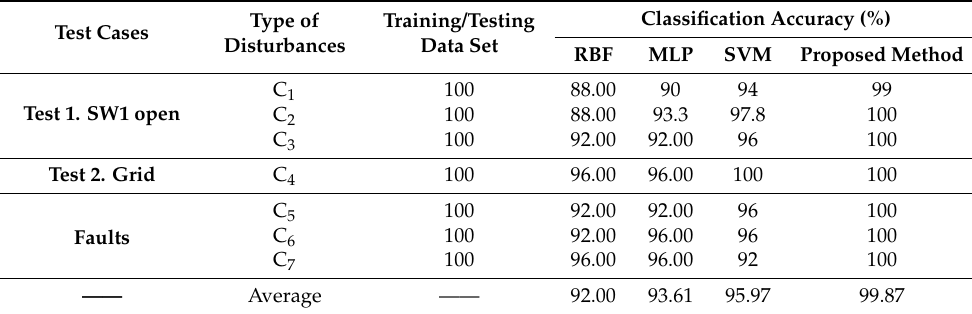
Table 9. Classification results for real time simulated test